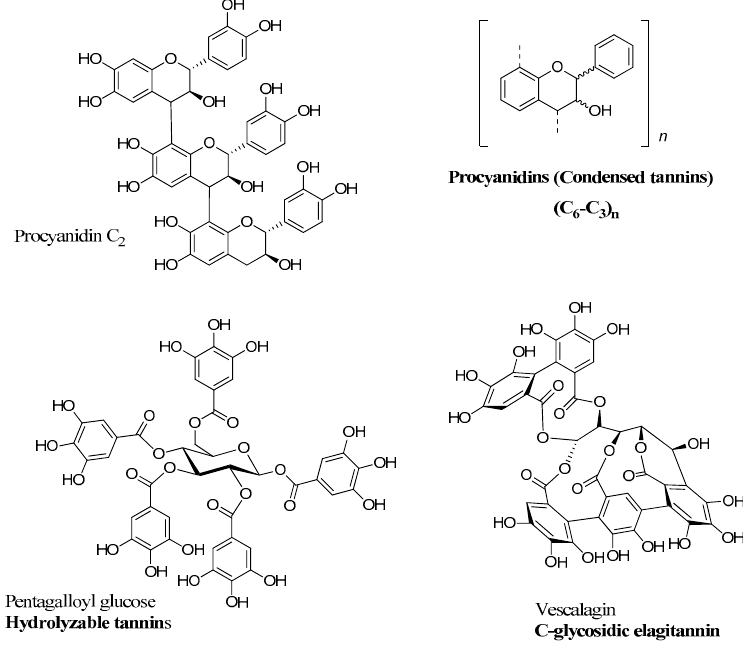
Figure 2. Examples of condensed (procyanidins), hydrolysable tannins and elagitannins.